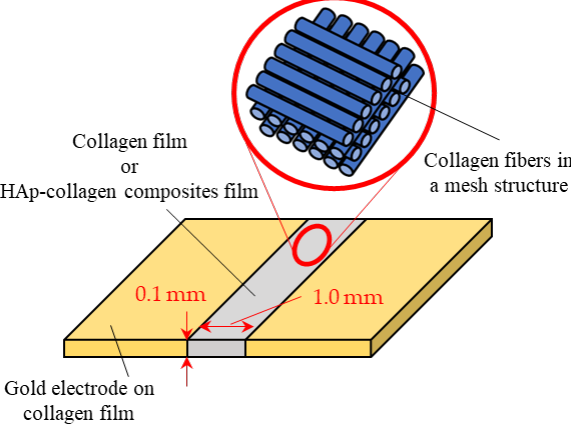
Figure 5. Schematic diagram of impedance